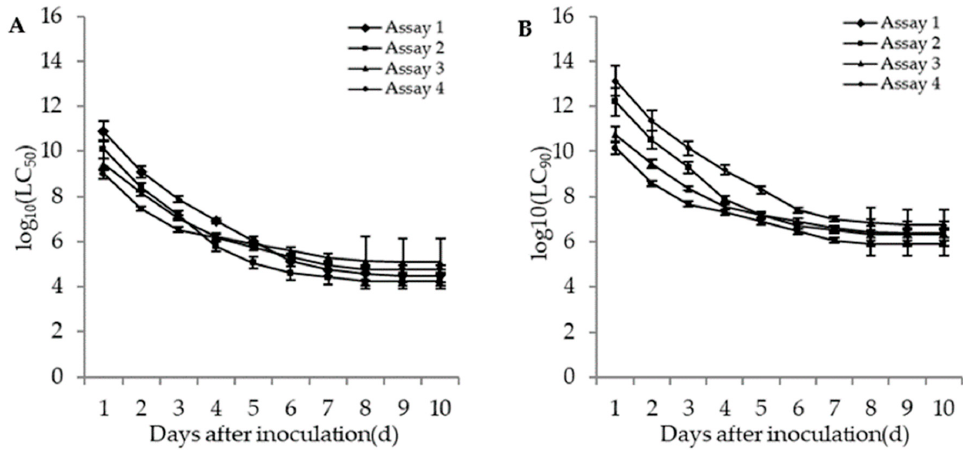
Figure 4. Curve trends in the logarithmic estimates of LC 50 ( A ) and LC 90 ( B ) (bars: SE) for assays 1 ( M. flavoviride applied at 1.2 × 10 6 and 1.2 × 10 8 conidia / mL alone), 2 ( M. flavoviride applied at 1.2 × 10 6 and 1.2 × 10 8 conidia / mL integrated with DE), 3 ( M. flavoviride applied at 1.2 × 10 6 and 1.2